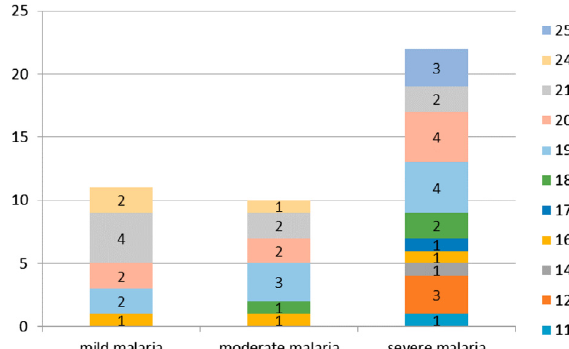
Figure 3. Mad20 allele distribution according to malaria clinical forms.